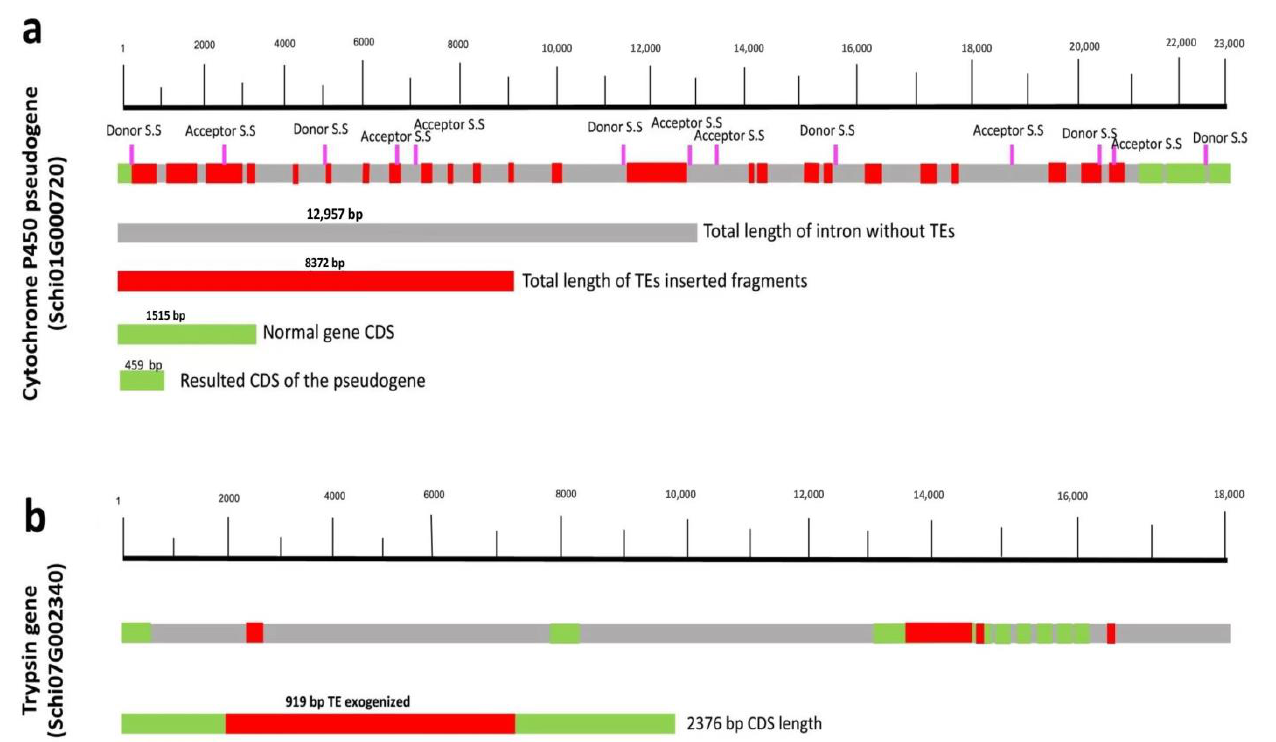
Figure 6. Graphical representation of TE insertion in the intron and exon of the functional gene in S. chinensis . ( a ) TE insertions (labeled red) in the intron (labeled grey) of the Cytochrome P450 pseudogene (SchiG000720). TE insertions contain several splicing sites, Donor and Acceptor (labeled pink), that could have led to the inactivation of the gene. The 1515 bp exon regions are labeled green. The scale at the top indicates the nucleotides’ position and sequence length. ( b ) TE insertions (labeled red) in the functional gene Trypsin (SchiG002340) show a 919 bp long TE fragment inserted in the exon of the genes without interrupting the coding activity, indicating its exogenization.